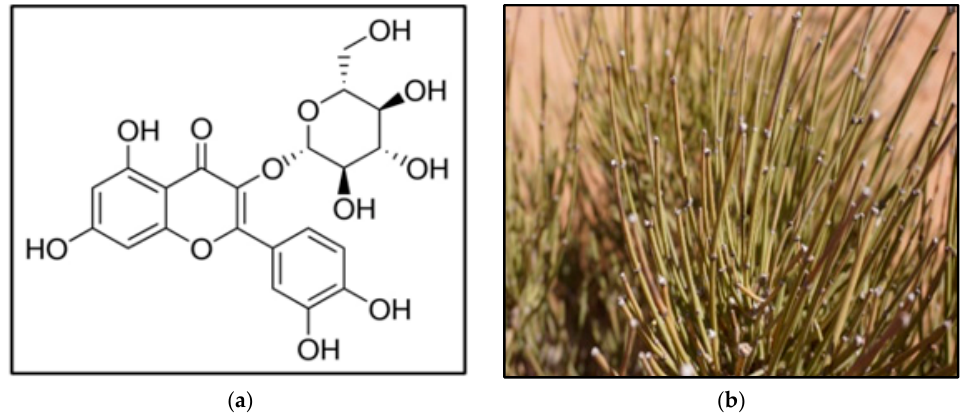
Figure 1. ( a ) Structure of quercetin 3-glucoside (isoquercetin, ISQ) , and morphology of E. alata ( b ).